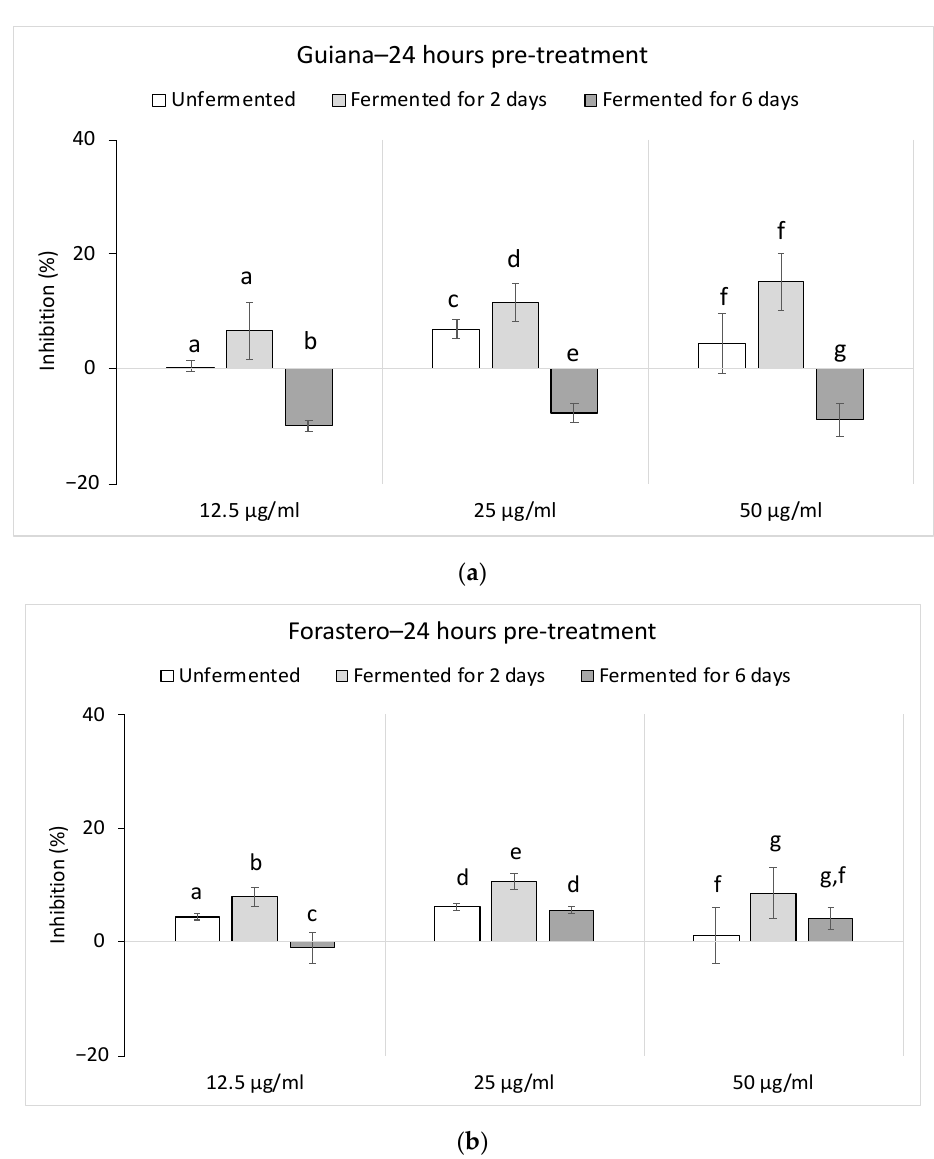
Figure 3. Inhibition rates of both varieties on nitric oxide (NO) production in lipopolysaccharide (LPS) and interferon gamma (IFNγ )-stimulated macrophages. ( a ) Guiana, ( b ) Forastero. Results represent the mean % inhibition of NO-production ± SEM ( n = 4). At each concentration, histograms with the same letter a–g for ( a ) or ( b ) were not significantly different ( p < 0.05) using a Mann–Whitney U test.